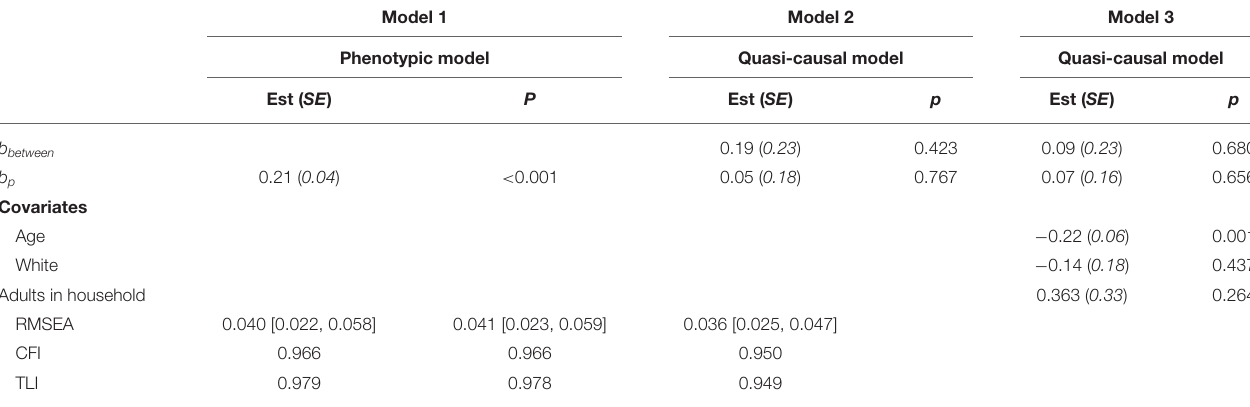
TABLE 5 | Unstandardized parameter estimates for phenotypic and biometric models estimating the effects of children in household on perceived stress